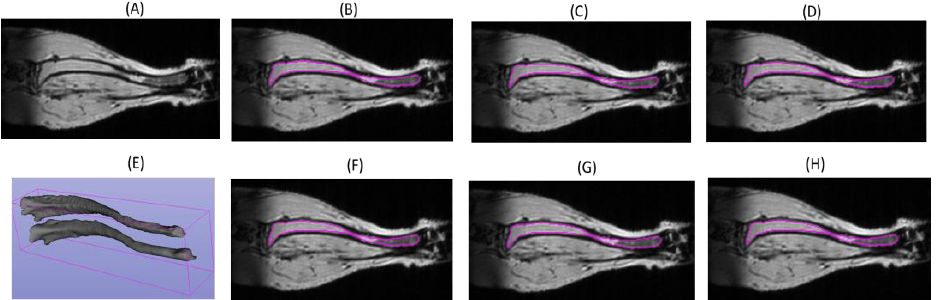
Figure 3. Examples of mouse tibia segmentation contours (magenta) for a single-slice MRI image in the test set ( A ) delineated by expert annotators (( B ) EA1; ( F ): EA2) and by DL model with different training scenarios; ( C ) full training subset; ( D ) TS1; ( G ) TSM; ( H ) TS2). ( E ) The full tibia 3D volume segmentation by EA1 for two scans (6 weeks apart) of the same mouse (top = 6.5 mm 3 ; lower = 9.9 mm 3 ).